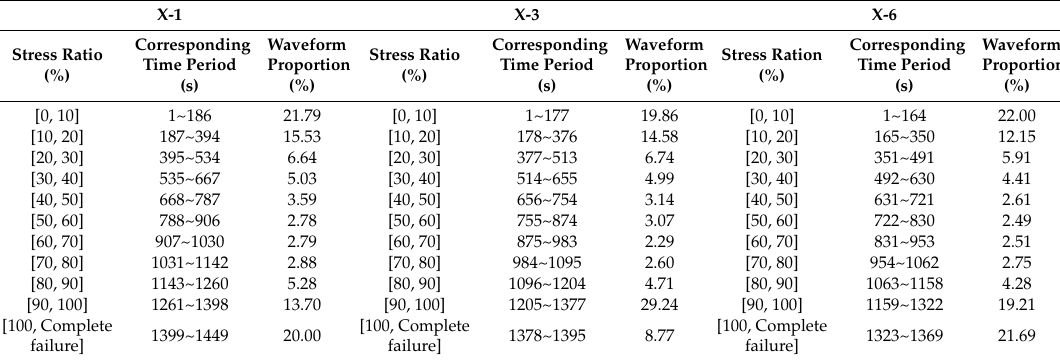
Figure 8. AE waveforms of specimens during the entire test. ( a ) X-1 specimen; ( b ) X-3 specimen; and ( c ) X-6 specimen. Table 2. Statistics of AE waveform proportion in each loading stress ratio interval of specimens.